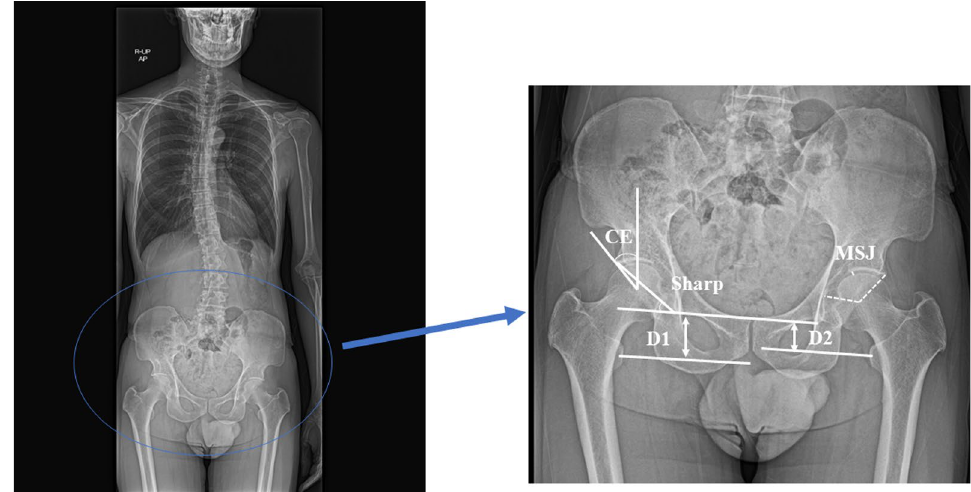
Fig. 2 Measurements of hip parameters. The CE angle was defined as the angle between the vertical line and the lateral edge of the acetabulum. The Sharp angle was defined as the line connecting the bilateral teardrops and the lateral edge of the acetabulum. MJS was defined as the narrowest point from the lateral edge of the acetabulum and fovea. Limb length discrepancy was calculated as the perpendicular distance from the line connecting the bilateral teardrops to the center of each lesser trochanter. Limb length discrepancy was defined as the length of the right side (D1) minus that of the left side (D2) and recorded as an absolute value. CE center edge, MJS minimum joint